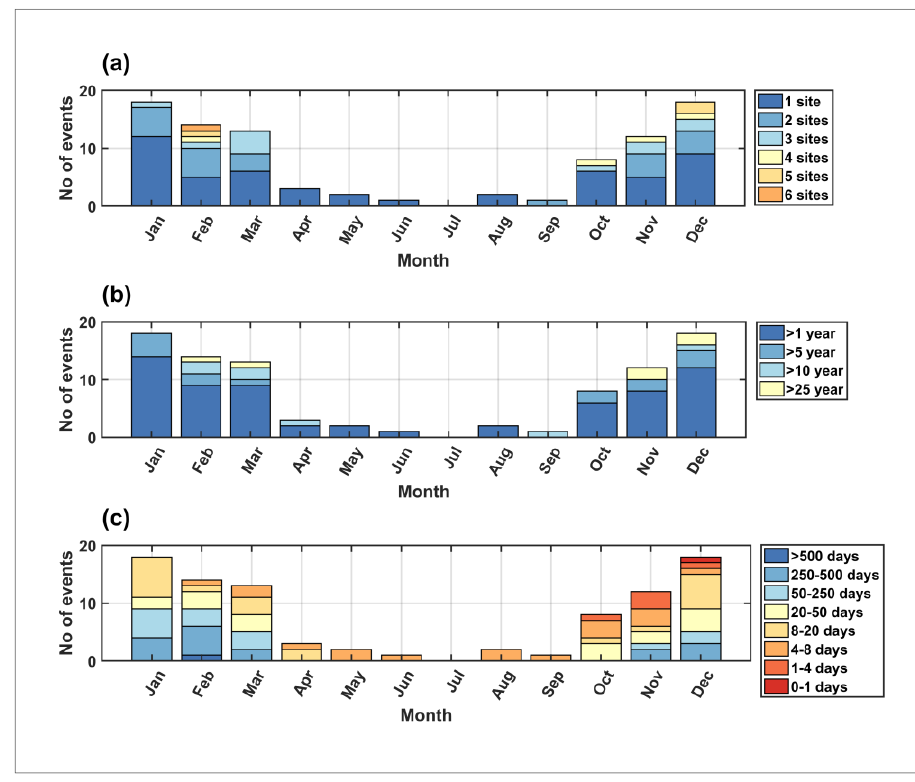
Figure 8. Number of significant wave height extreme events per month for ( a ) distinct number of sites affected (i.e., spatial footprint), ( b ) different return level threshold, and ( c ) ranges of days between events.